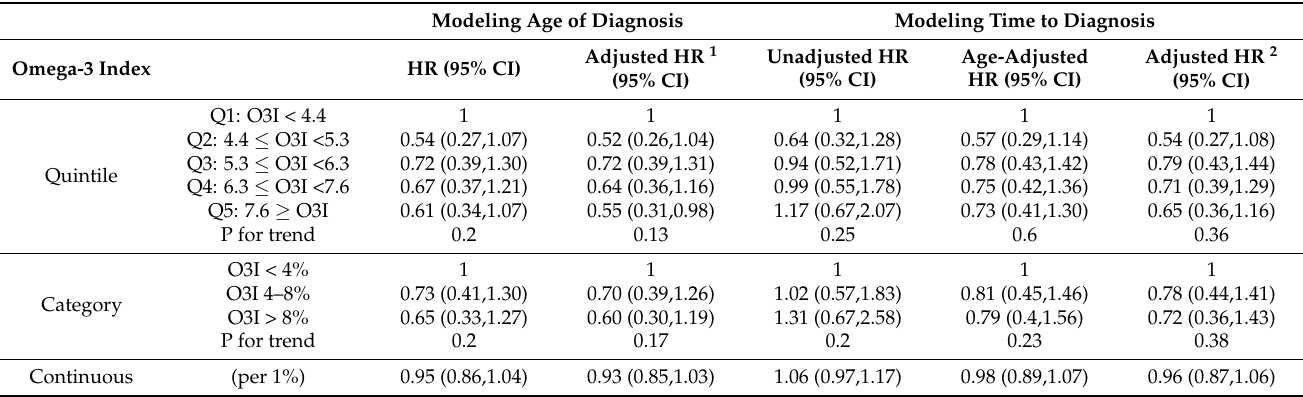
Table 2. Risk for a prostate cancer diagnosis and the Omega-3 Index (O3I): hazard ratios (HRs) from models for age of diagnosis and time to diagnosis by quintile, by category and continuously (per unit (1%) increment in